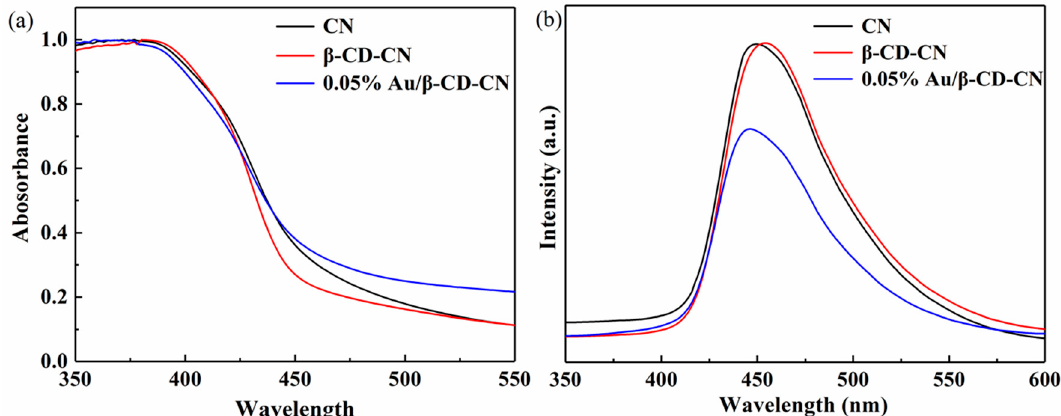
Figure 4. ( a ) Ultraviolet–visible (UV–vis) diffuse-reflectance spectra and ( b ) photoluminescence (PL) spectra of CN, β -CD-CN, and 0.05% Au/ β -CD-CN.